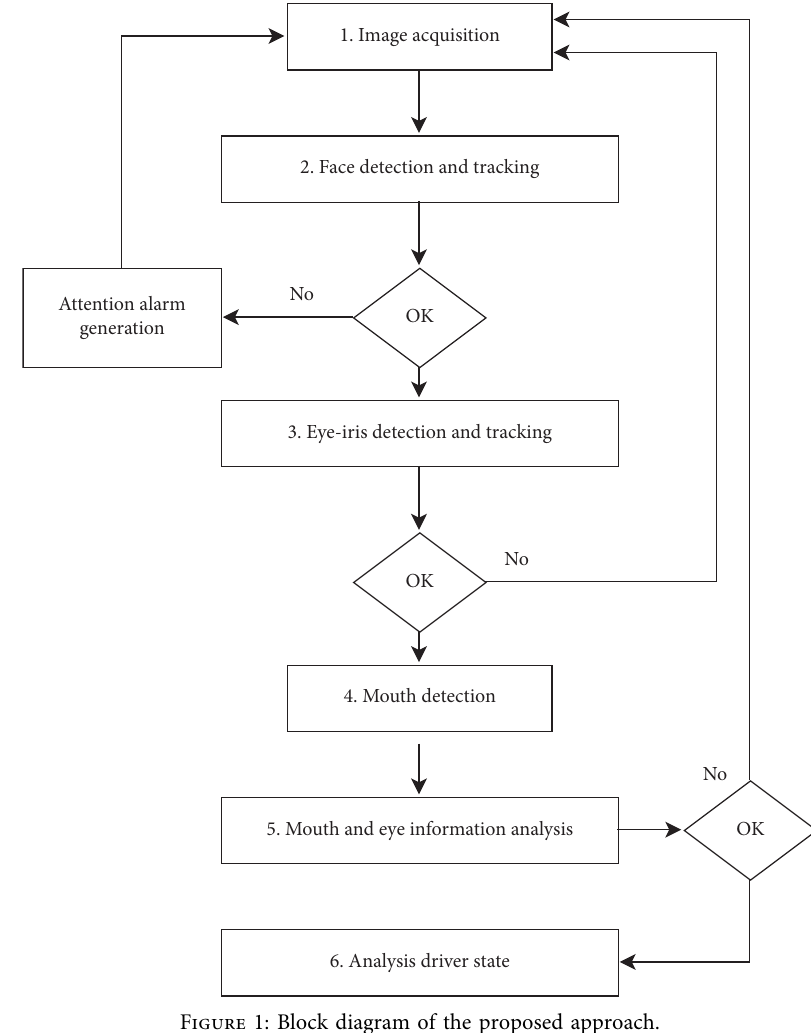
Figure 1: Block diagram of the proposed approach.